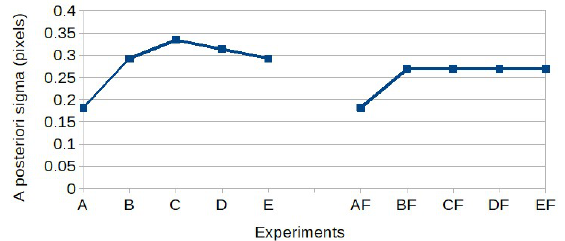
Figure 4. A posteriori sigma (sigma naught) for all experiments.